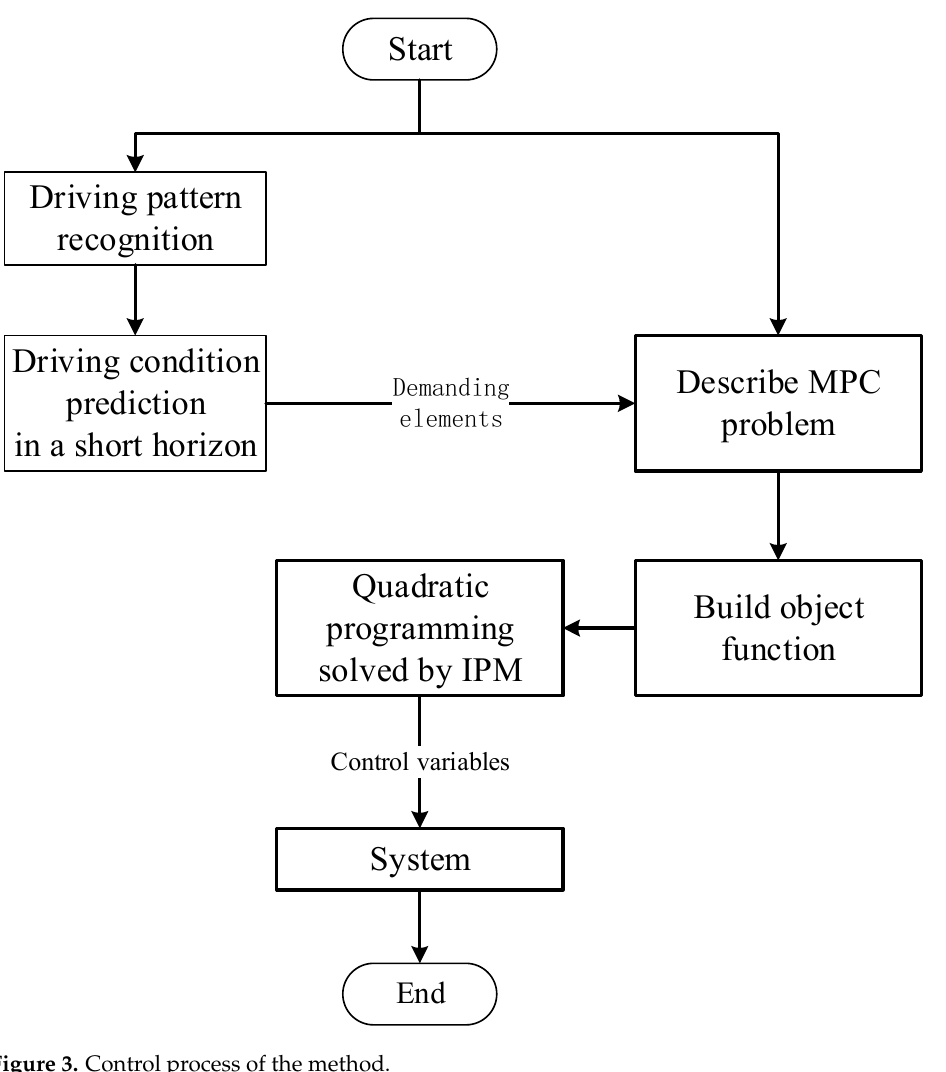
Figure 3. Control process of the method.